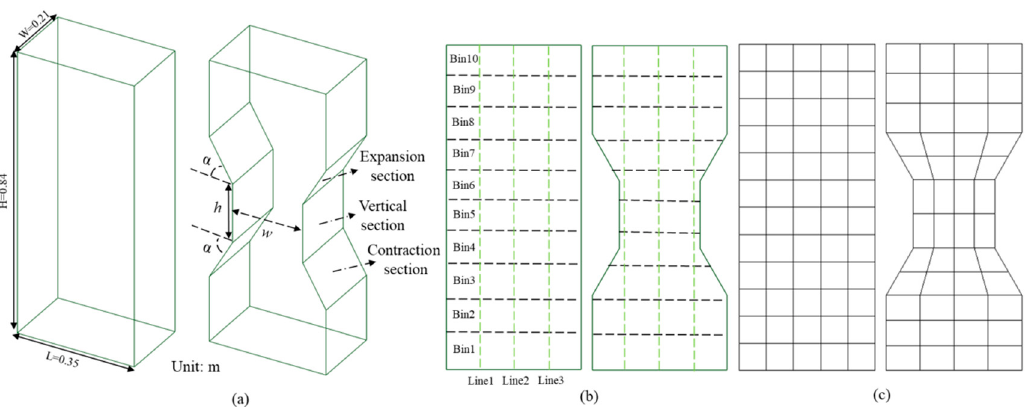
Figure 1. Schematic of physical model. ( a ) Vertical structure and variable-diameter structure; ( b ) bins and lines location; ( c ) computational grid. Table 1. Material properties and simulation parameters.